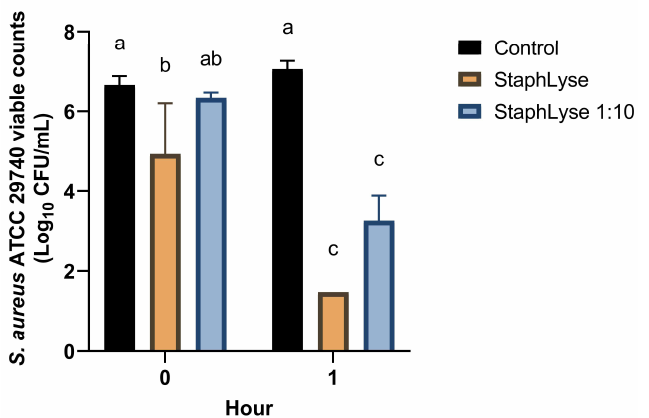
Figure 5. StaphLyse™ in vitro killing of S. aureus ATCC 29740 in whole milk. The average of four experiments is presented, and error bars represent SEM. Bars with different letters are significantly different ( p < 0.05) from one another.